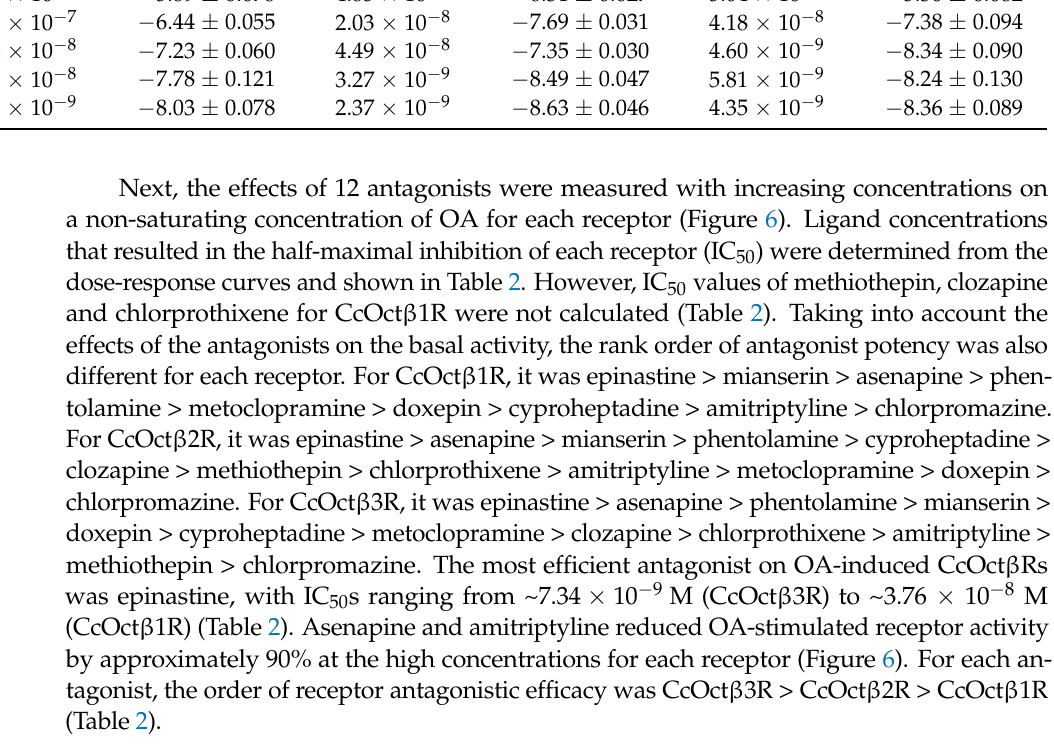
Table 2. IC 50 and LogIC 50 values for inhibition of OA-induced cAMP response in CcOct β R-expressing CHO-K1 cells by various